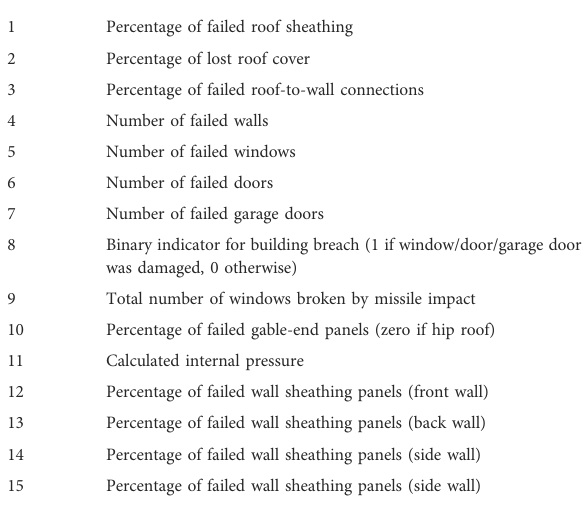
TABLE 1 Components evaluated for